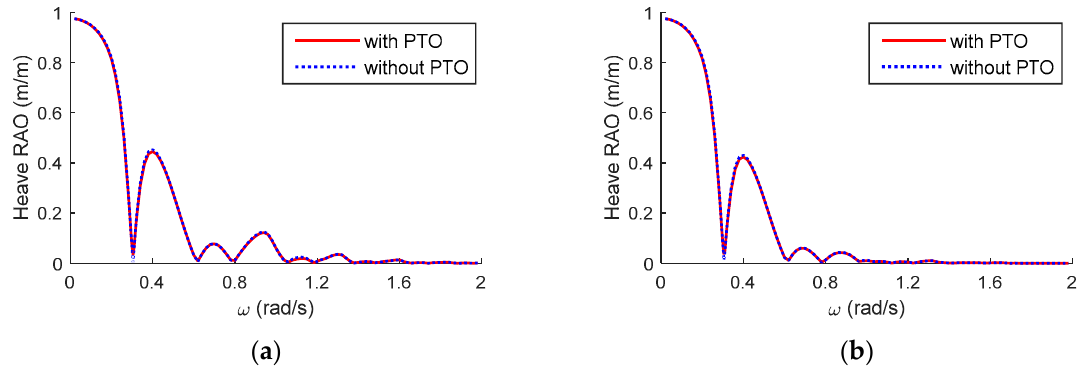
Figure 8. Platform heave RAOs: ( a ) Wave-heading angle is 0.0 deg; ( b ) Wave-heading angle is 22.5 deg.